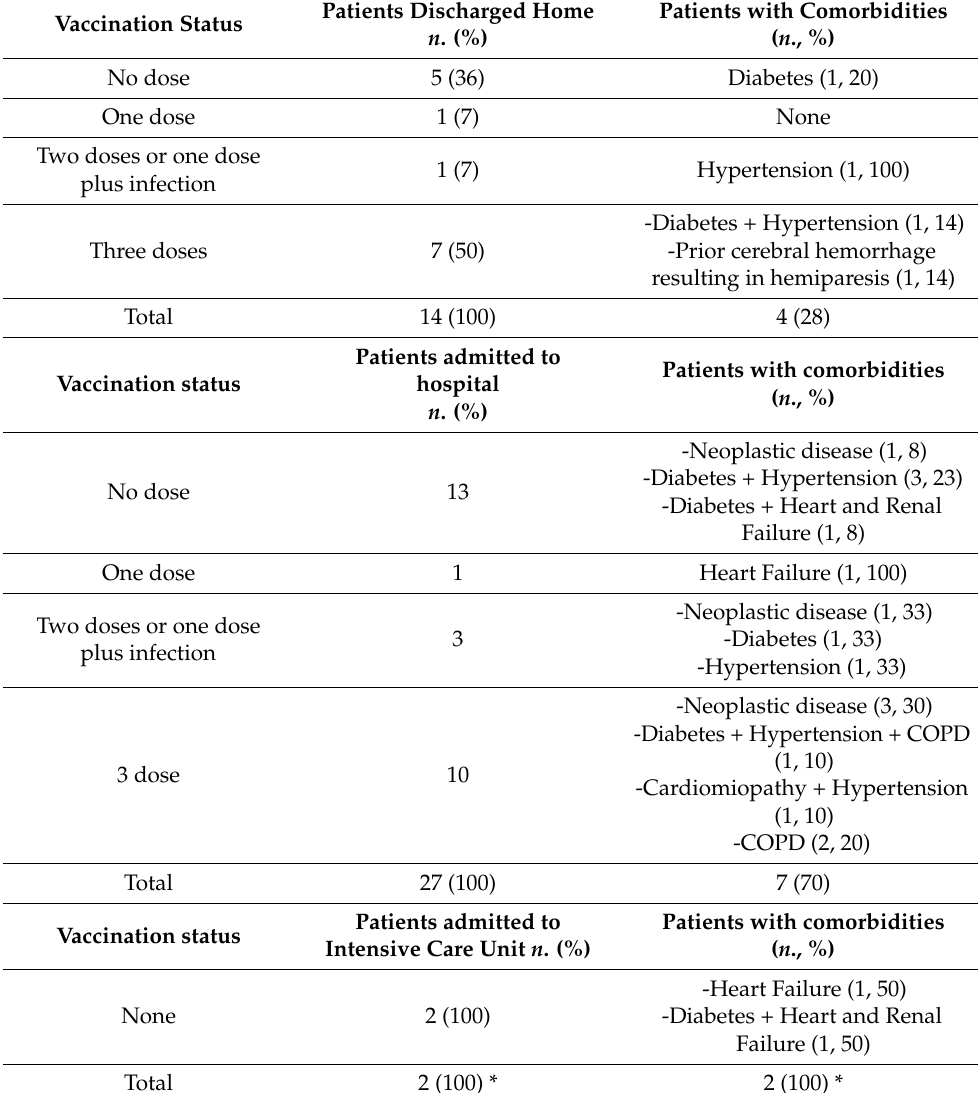
Table 2. Vaccination status and patient management shown in conjunction with the patients’